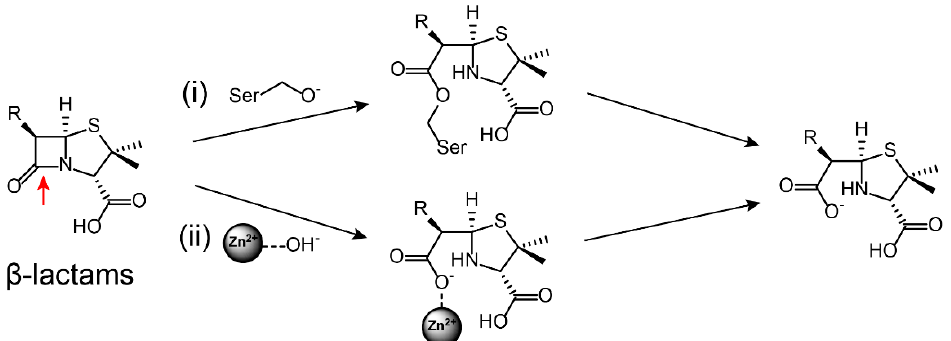
Figure 2. β‐ Lactams are hydrolized by ( i ) Ser ‐β‐ lactamase and ( ii ) metallo ‐β‐ lactamase [21]. The hydrolysis site on the antibiotic is marked by red